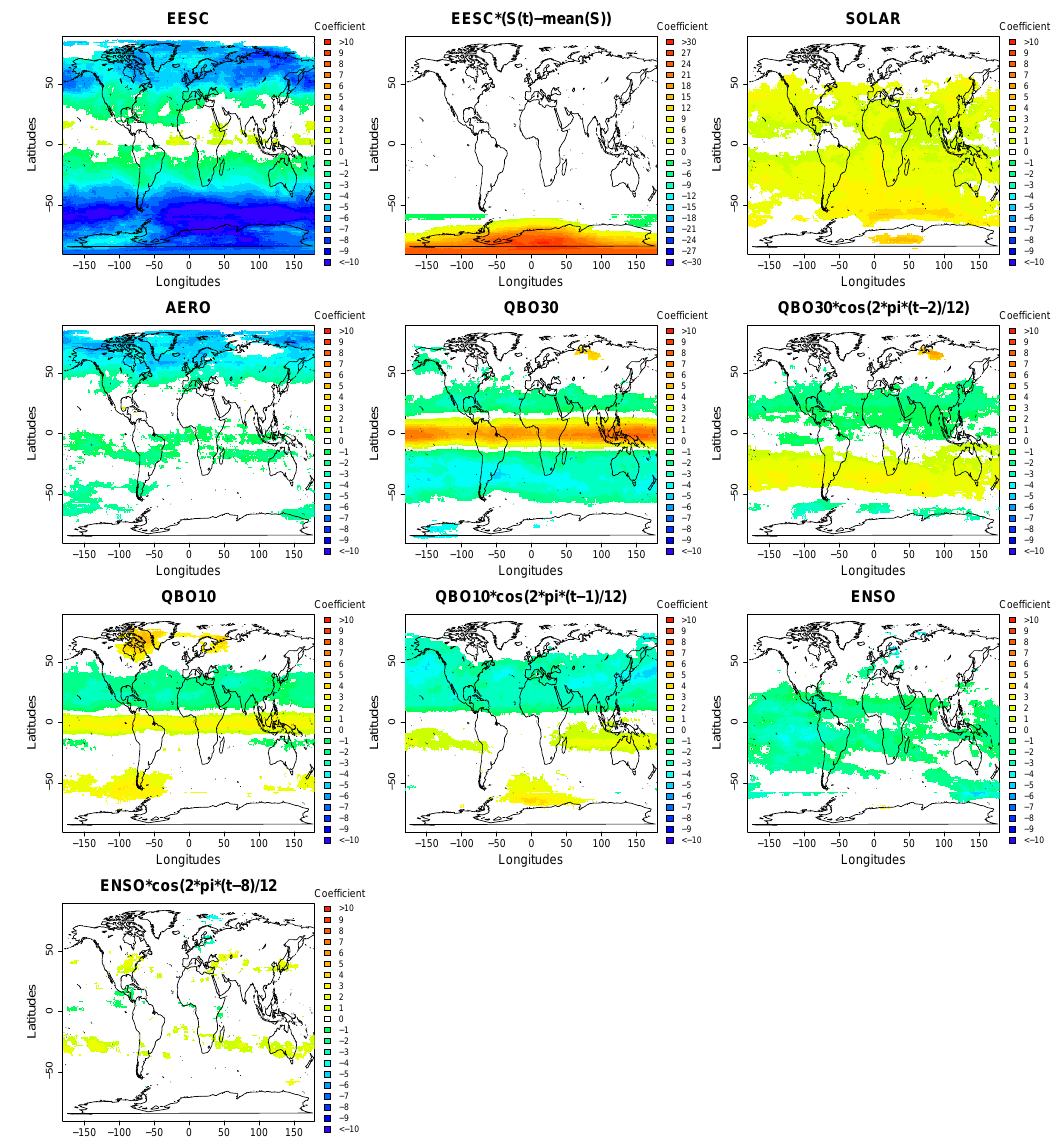
Figure 4. Regression coefficient estimates of nonseasonal variables for the PHYS model on a 1 × 1.5 ◦ grid. White regions indicate non- significant regression estimates at the 99% confidence level. QBO10 and QBO30 represent the QBO index at 10 and at 30hPa, respectively. The coefficients are in DU per unit change of corresponding normalized explanatory variable. Note the different color bar range for the alternative EESC variable (a range of − 30 to 30 against − 10 to 10 for the other plots). Table 3. Overview of variables included in the regression models with “group A” consisting of EESC, SOLAR, AERO, ENSO and their corresponding alternative explanatory variables, “group B” consisting of DAY, EP, PV and GEO and “Fourier terms” consisting of sines and cosines with periods of a year and half a year.